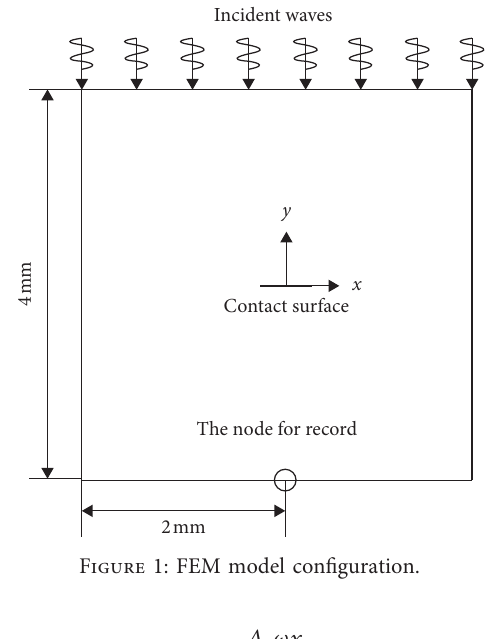
Figure 1: FEM model